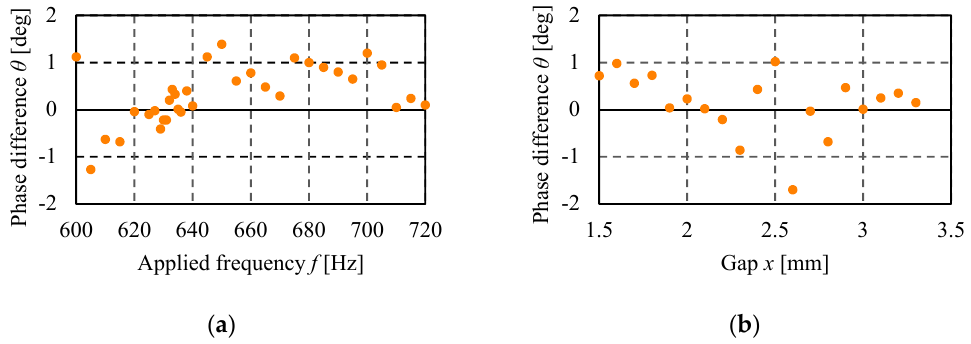
Figure 12. Characteristics of the phase difference between the primary and secondary currents: ( a ) when the gap x is 2.0 mm; ( b ) when the applied frequency is 650 Hz.